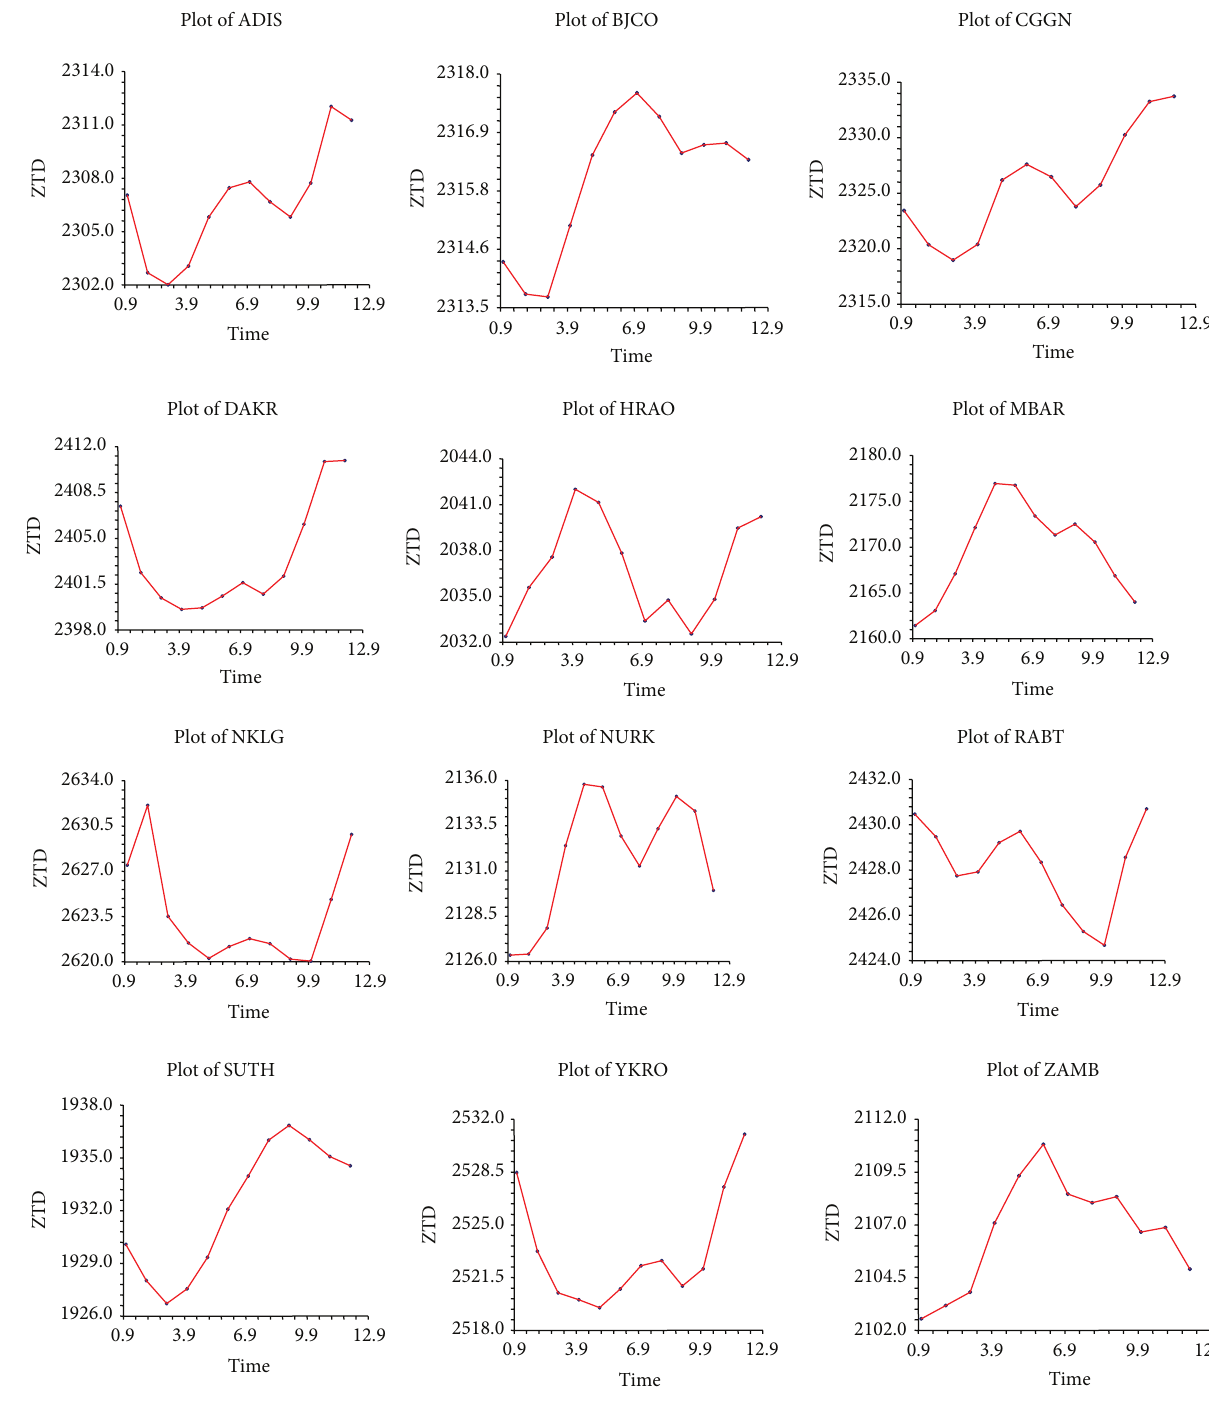
Figure 6: Average two-hourly ZTD plots for